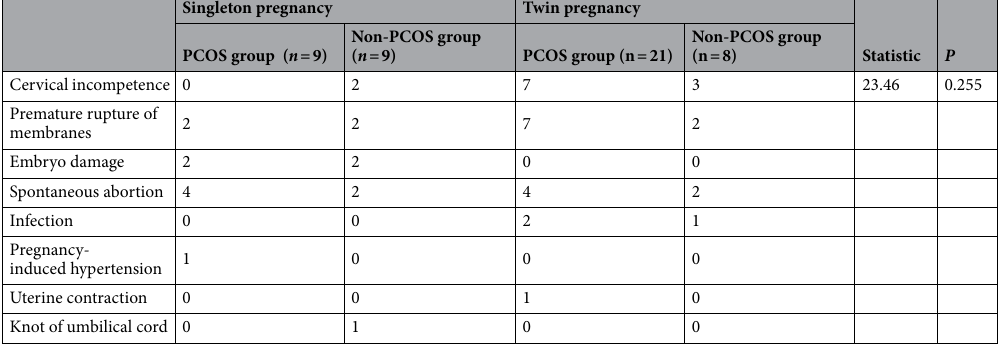
Table 3. Etiology distribution of late abortion in the PCOS and non-PCOS groups after PSM. PCOS, polycystic ovary syndrome; PSM, propensity score matching.